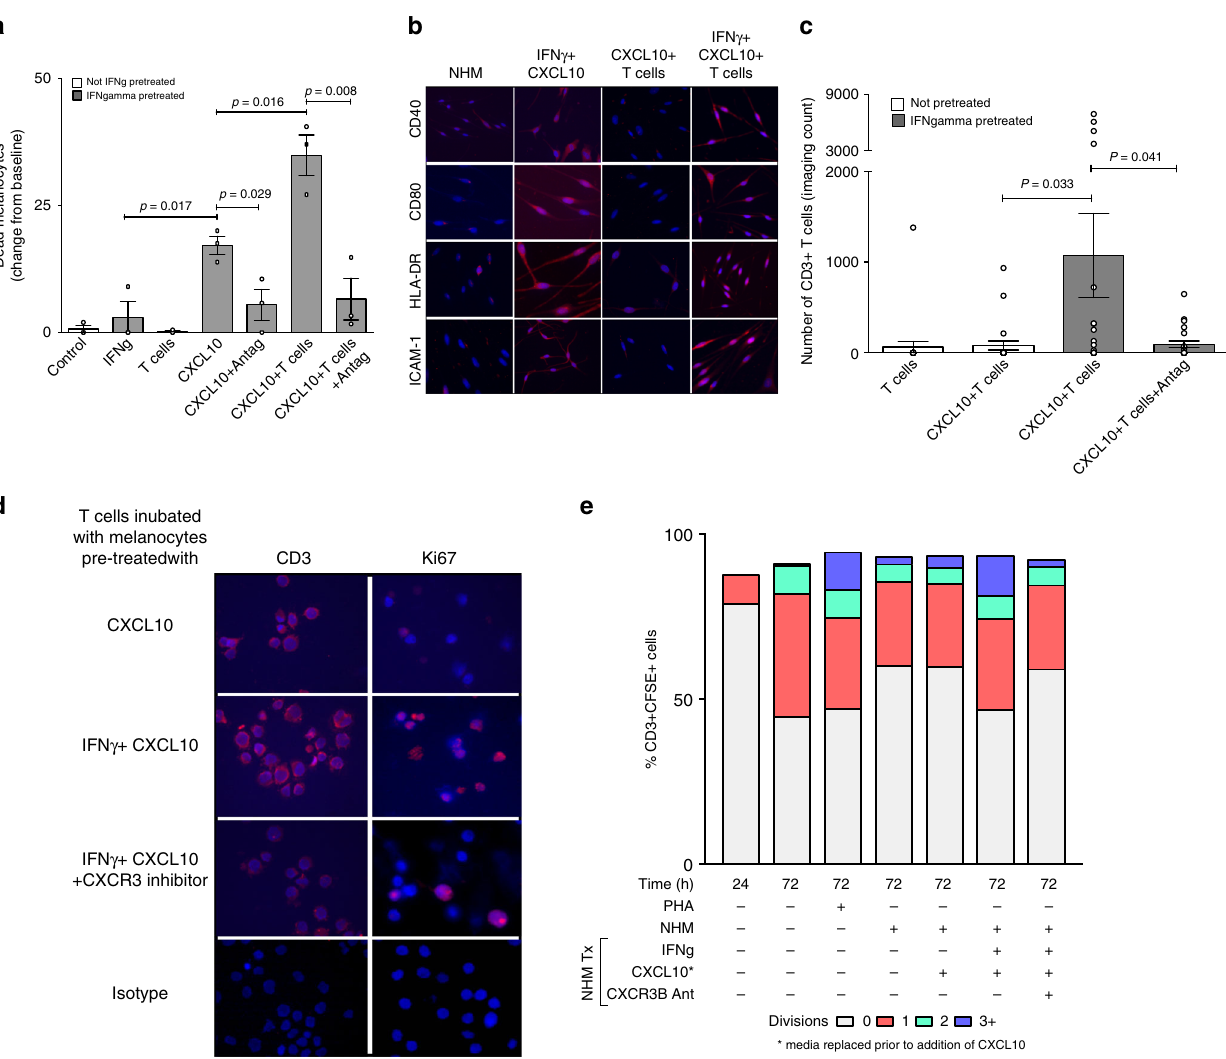
Fig. 5 T cells enhance CXCL10-induced melanocyte death by induction of adaptive immunity. a CXCL10-induced death of vitiligo melanocytes in presence or absence of patients own autologous T cells. As above, IFN γ -pretreated melanocytes were exposed to CXCL10 in presence or absence of CXCR3 antagonist AS612568 (2 μ M). The next day, media was replaced and 3 days later patient ’ s own CD3 + T cell were sorted and added to the melanocytes ( n = 3) prior to initiation of IncuCyte. b At the end of the experiment (~48h), supernatant was collected, remaining cells trypsinised and cytospin sections prepared for immuno fl uorescence detection of co-stimulatory (CD40, CD80, HLA-DR) and adhesion (ICAM-1) molecules on melanocytes. c T cell- induced potentiation of melanocyte death in IFN γ -pretreated melanocytes (compared to untreated melanocytes) was associated with a parallel increase in the number of CD3 + T cells which was supported by increased expression of Ki67 + cells in the same cytospin sections d . Results are shown as individual dot plots with a line at mean ± SEM. e T cell proliferation was quanti fi ed by fl ow analysis measuring the percentage of CD3 + CSFE + cells undergoing 0, 1, 2 or 3 + divisions ( n = 3). Labelled cells at time zero was used as a negative reference, unstimulated cells left in culture for 72 h before labelling as a control and cells stimulated with PHA for 72 h (Phytohemagglutinin, 5 μ g/ml) as a positive